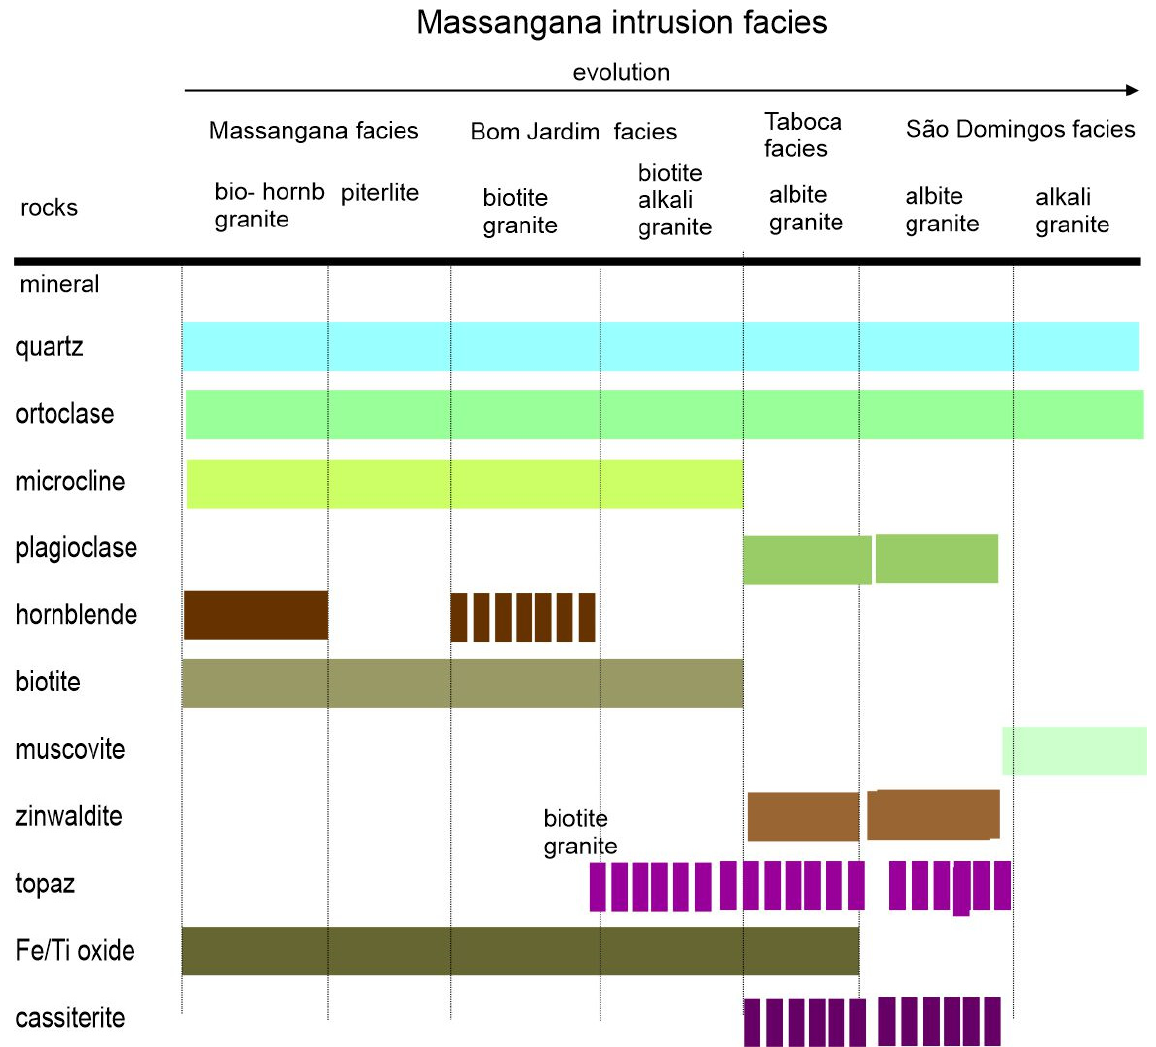
Figure 7. Evolution table of Massangana granite facies from their mineral paragenesis. The biotite and hornblende granite is interpreted as the first to be crystallized, followed by the Bom Jardim. The S ã o Domingos and Taboca facies present equivalent mineralization and petrographic variations and are interpreted as the final stages of the magmatic fractionation